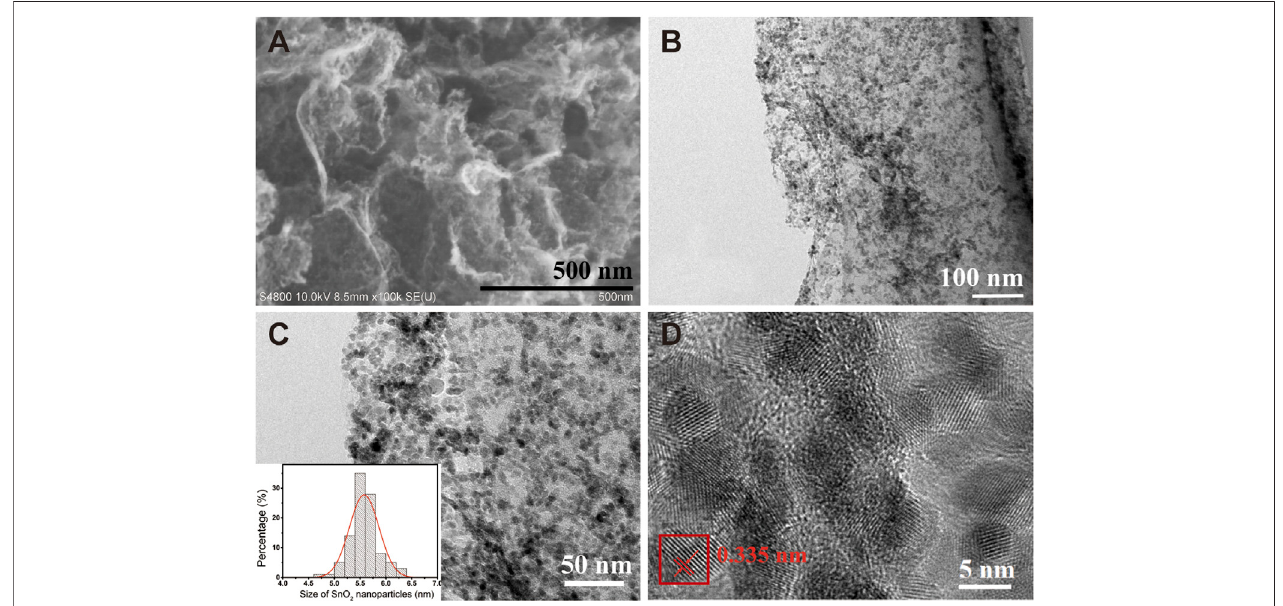
FIGURE 3 | (A) The relative responses of SnO 2 /rGO composite-based sensors to different gases (NO 2 , CO 2 , C 7 H 8 , C 6 H 6 , CH 2 O, and NH 3 ) at 116 ° C; (B) The response curves to 750 ppb NO 2 at the increasing operating temperature of 33, 63, 116, 189 ° C; (C) The response curve to 750 ppb NO 2 of sensors based on SnO 2 / rGO composites at 116 ° C; (D) The relative responses to different concentrations of NO 2 (50 – 1500 ppb) under dry air.